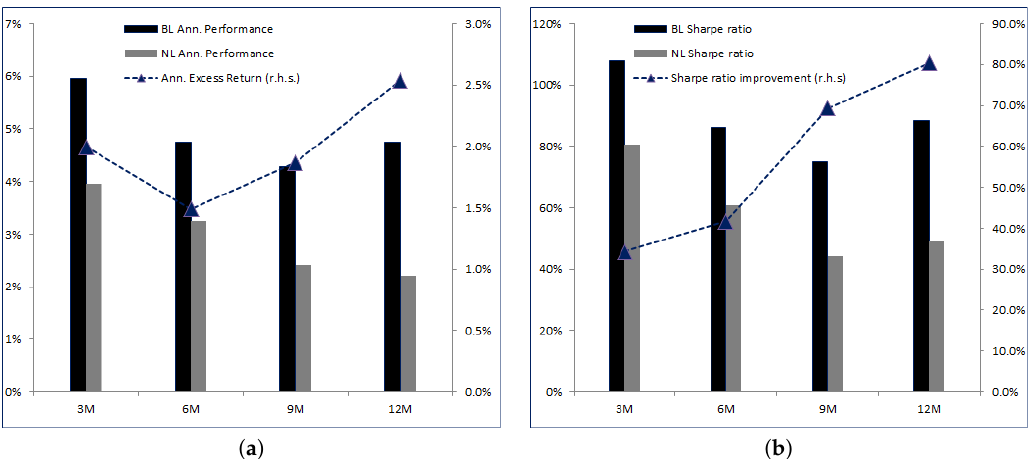
Figure 5. Annualized performances and excess returns of BL as a function of L ( a ); Sharpe ratios and relative improvement ( b ).